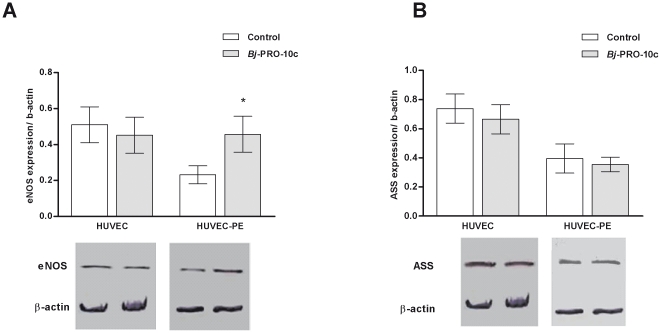
Analysis of eNOS and ASS protein levels in HUVEC and HUVEC-PE.Endothelial cells were incubated for 24 h in serum-free medium in the absence (control) or presence of 1 µM Bj-PRO-10c. Then, cells were lysed and 50 µg of cell homogenate proteins were used for Western-blot analysis as detailed in Materials and Methods. Relative quantification of eNOS (A) and ASS (B) expression levels was obtained by densitometry scanning. β-Actin immunostaining was used as endogenous control for normalizing of protein expression. Data (mean values ± S.E.) are representative for three independent experiments. * P<0.05 compared to untreated control HUVEC-PE.